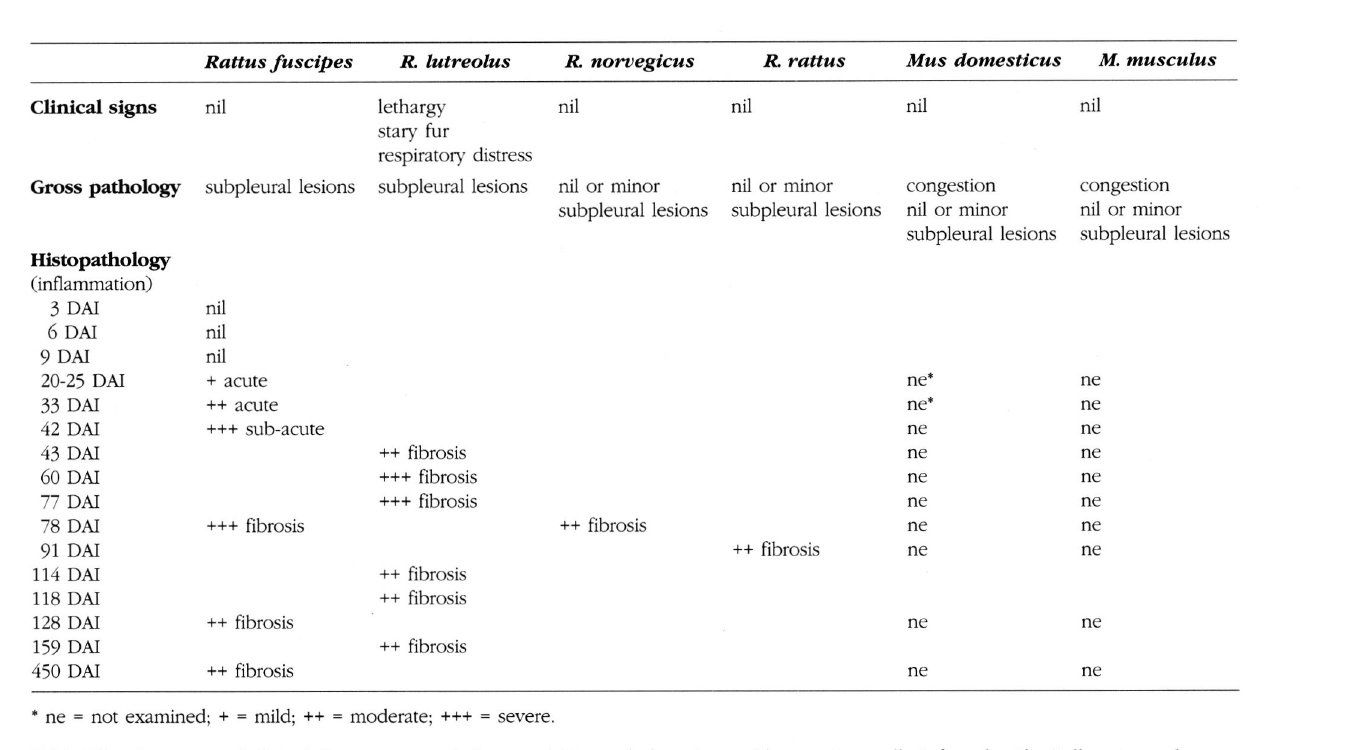
Table III. - Summary of clinical signs, gross pathology and histopathology in murids experimentally infected with Gallegostrongylus aus- tralis Spratt, Haycock & Walter,